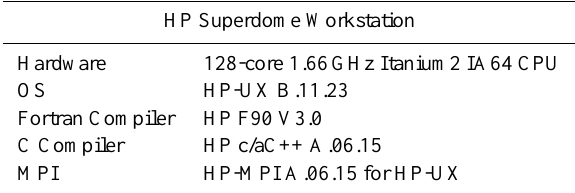
Table 1. Computer